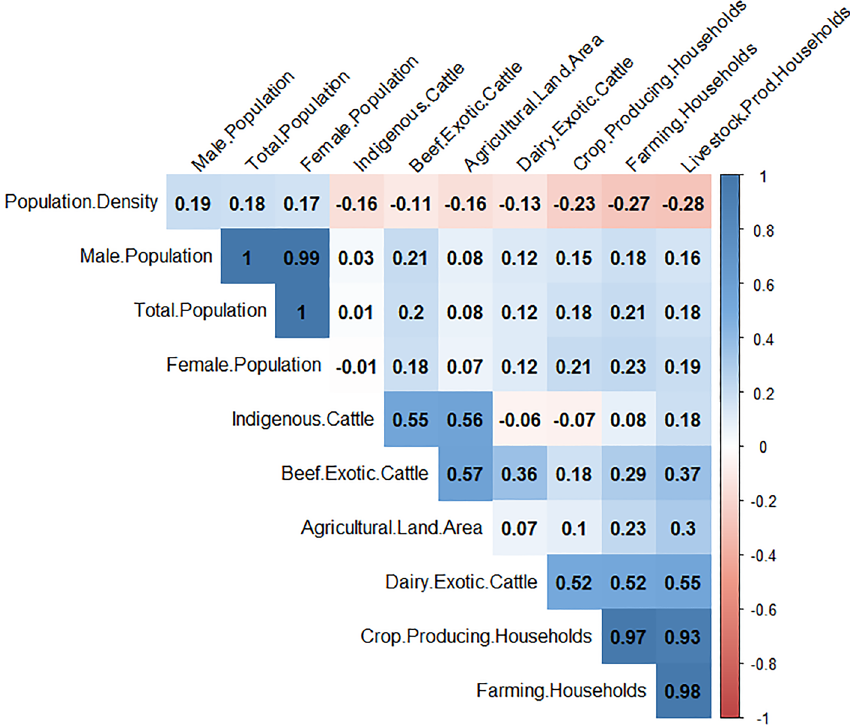
Figure 2. Results of correlation between covariates using Pearson’s correlation coefficient test for the spatiotemporal model. Correlation between covariates is shown by red numbers (negative correlation) and blue numbers (positive correlation). Correlations with a p-value > 0.01 are regarded as insignificant and the correlation coefficient values are left blank. The figure was generated using R software v. 4.1.0 28